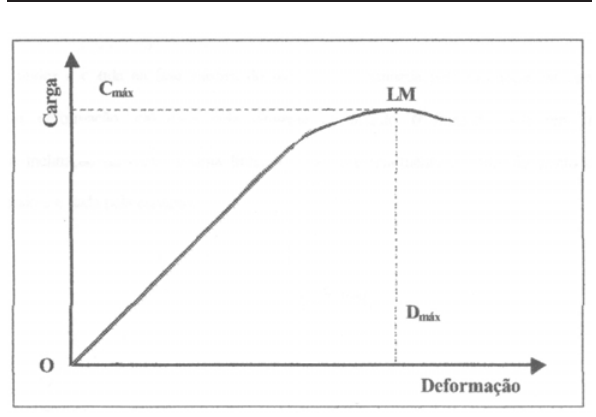
FIGURA 4 – Carga versus deformação, a partir do qual são obti - das as propriedades mecânicas. LEGENDA: